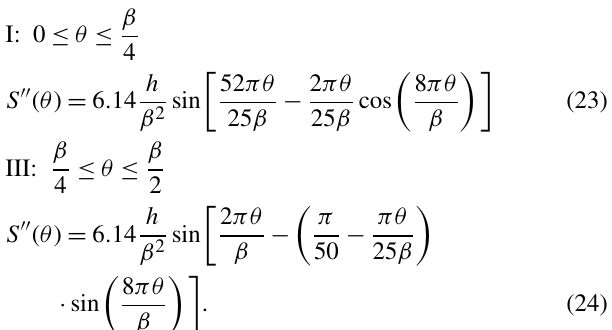
Figure 7. Variation in normalized motion program in Example